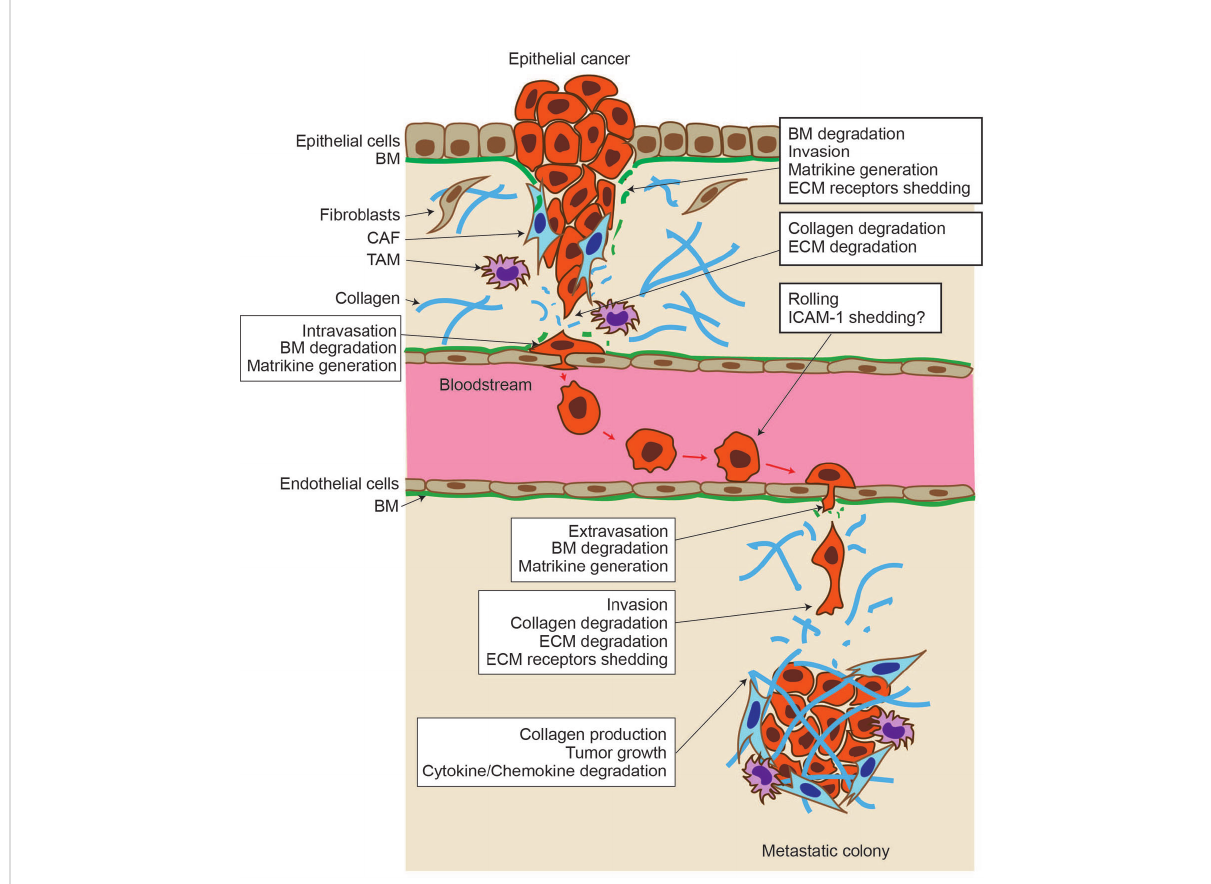
FIGURE 1 Proteolytic events during cancer progression. Epithelial cancer arises within the epithelial layer. They break through the basement membrane (BM) and invade stromal tissue. Upon BM degradation, matrikines are generated by proteolytic action, and cell surface extracellular matrix (ECM) receptor shedding promotes cancer cell motility. Stromal fi broblasts are activated and become cancer-associated fi broblasts and help cancer cells further invade. Tumor-associated macrophages (TAMs) help to evade the immune system. Cells degrade stromal the ECM further, including type I collagen, and intravasate into the vessel. Cancer cells traverse other organs through the bloodstream, interacting and rolling on the endothelial cell layer. Intercellular adhesion molecule – 1 may be expressed in cancer cells, and its shedding allows cancer cells to migrate through the endothelial cell layer and extravasate. Cancer cells invade stromal tissue, form a metastatic colony, create a tumore microenvironment, and cause tissue